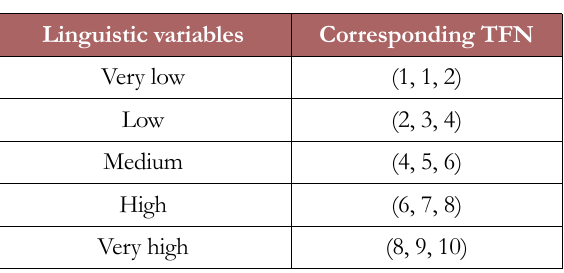
Table 3. Linguistic variables for